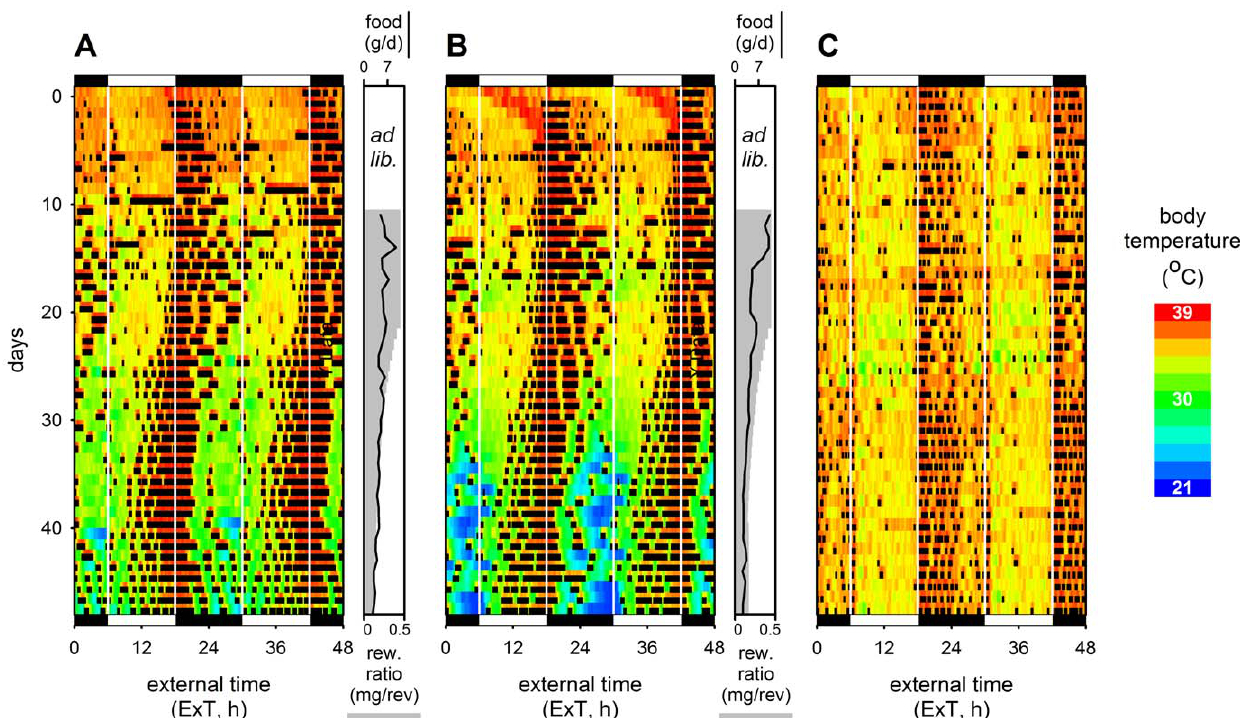
Figure 2. Reward reduction causes diurnal activity and eventually reduces body temperatures. ( A , B ) Two example actograms and body temperature patterns of mice under a reduced reward ratio protocol (grey bars) and ( C ) a control mouse kept under ad libitum conditions. Low daily food rewards (side panels, black lines) eventually elicited torpor response (blue colors) after activity patterns shifted to the light (see also Fig. S3). No evidence of torpor was found in any of the control mice. Black and white bars indicate the light-dark cycle to which the mice were exposed throughout the experiment.